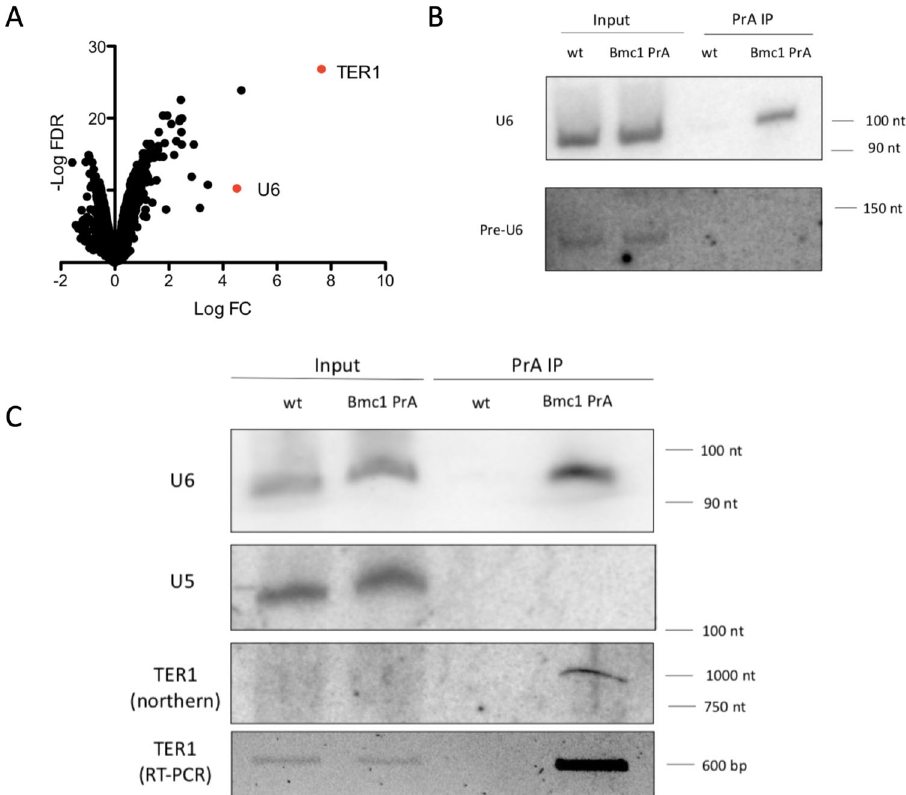
Fig. 1 Bmc1 interacts with U6 snRNA and the telomerase RNA TER1. A Enrichment of Bmc1 PrA immunoprecipitated transcripts compared to an untagged control (biological replicates = 3). Axes represent log2 of fold change (FC) and negative log of false discovery rate (FDR) (Benjamini – Hochberg adjusted P value ≤ 0.05). B Northern blot analysis of the mature and intron-containing U6 from total RNA and PrA immunoprecipitates from untagged (wild type, wt) and PrA-tagged Bmc1 strains. C Northern blot of the telomerase RNA TER1, U6, and U5 from total RNA and PrA immunoprecipitates from untagged and PrA-tagged Bmc1 strains, and semi-quantitative RT-PCR analysis of TER1. Source data are provided as a Source Data fi